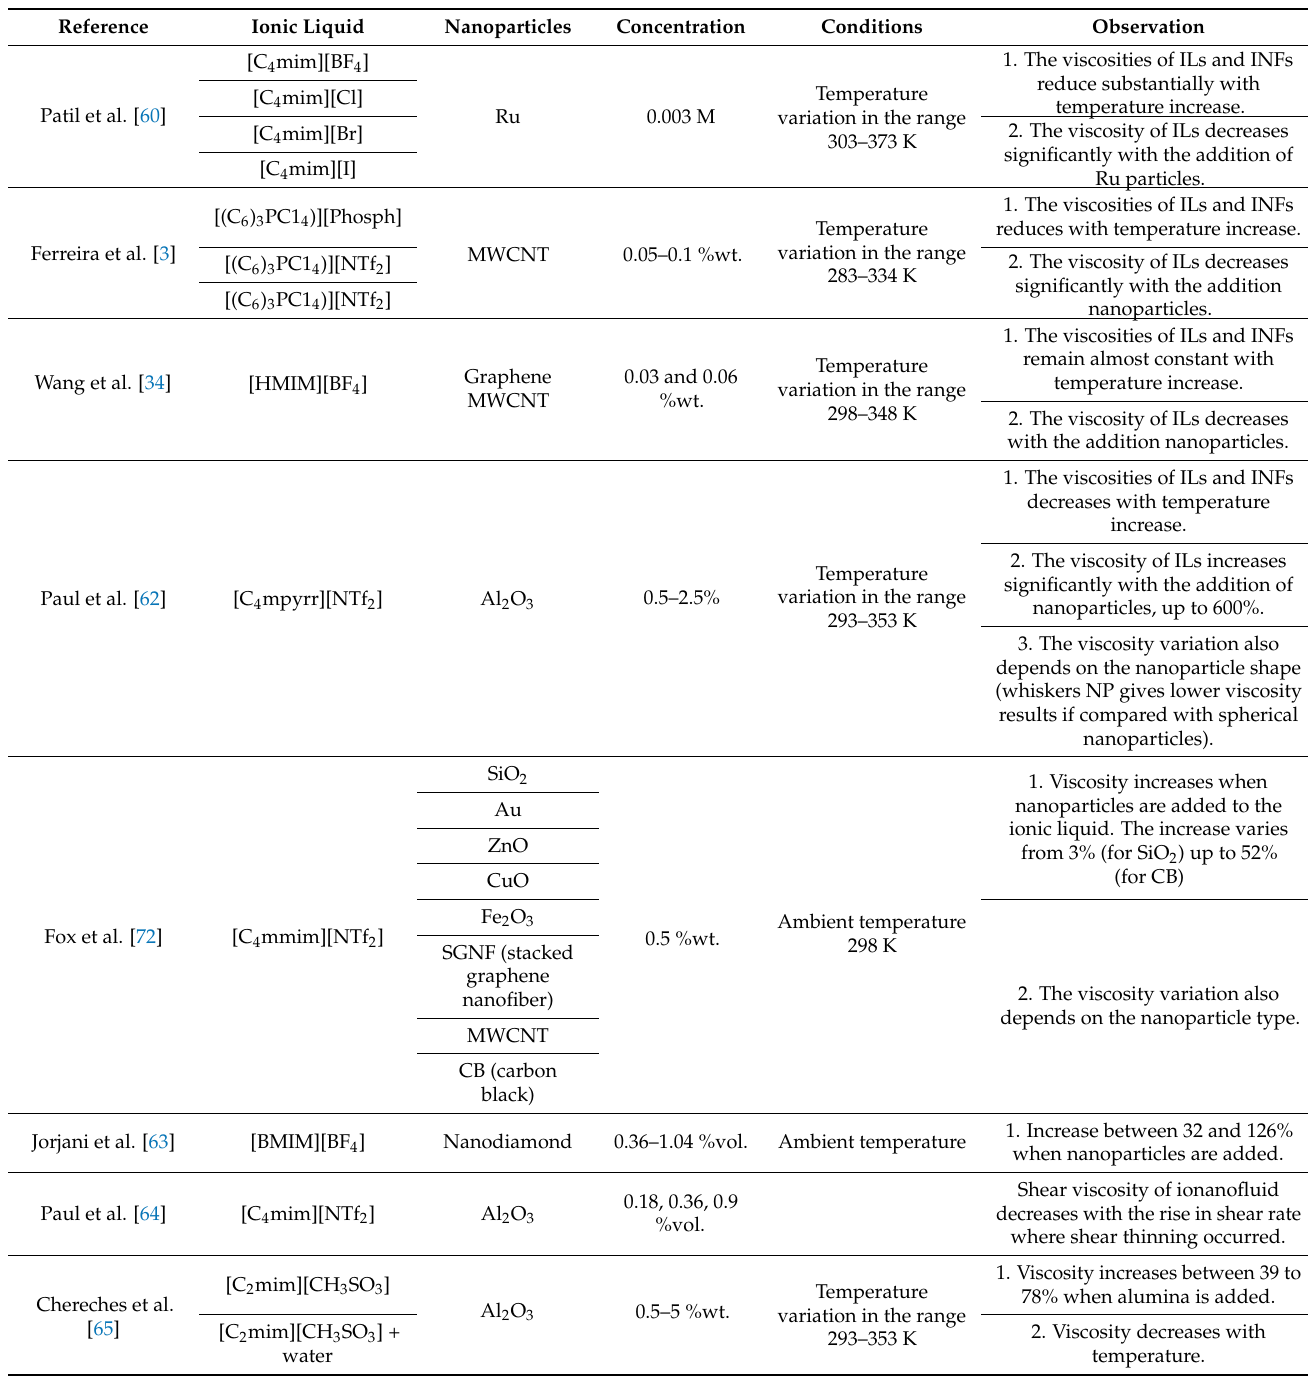
Table 4. Literature results on viscosity of ionic liquid-based